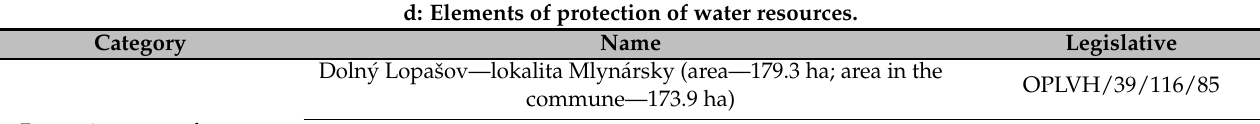
Table 1. Cont. d: Elements of protection of water